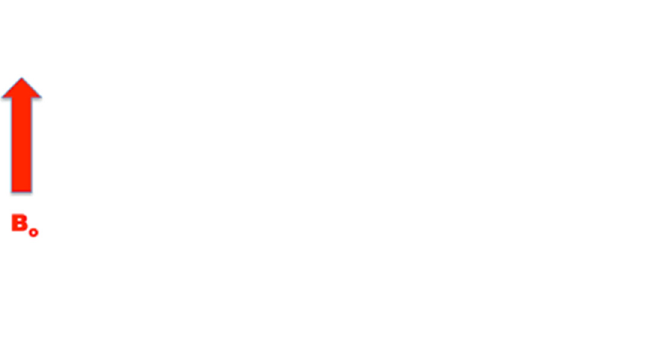
Figure 4. Intuitive representation of the phase transition between the non-ferromagnetic ( left ) and ferromagnetic phases ( right ) of a metal.